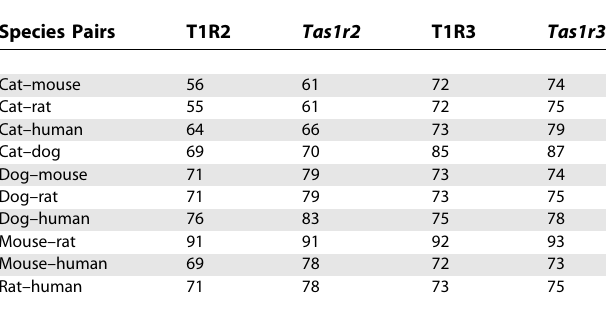
Table 1. Similarity of Sweet Receptors between Species Species Pairs